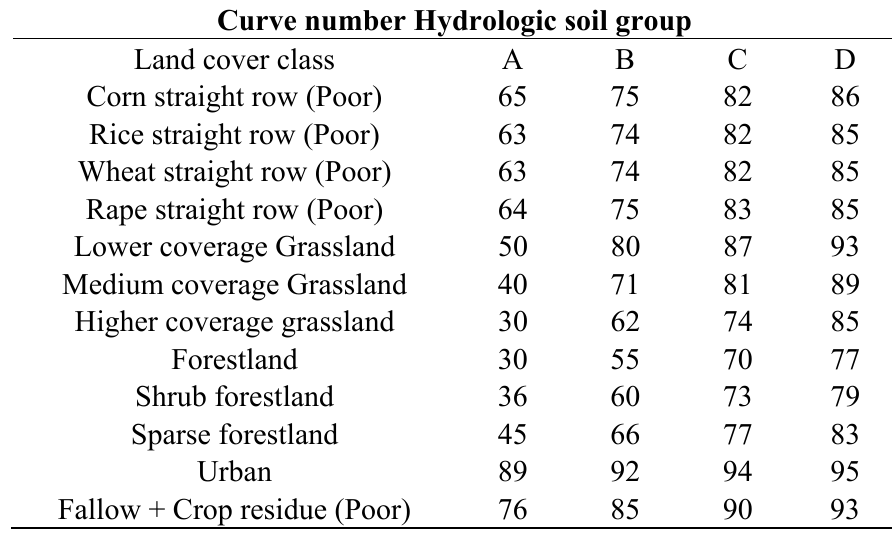
Table 7. Estimated SCS curve numbers for the Daning River watershed used in the model